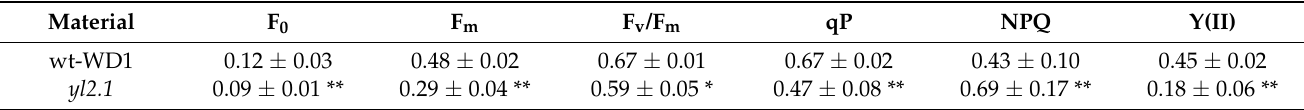
Table 3. Chlorophyll fluorescence kinetic parameters of young leaves of yl2.1 and wt-WD1. For each sample, five indepen- dent biological replications were performed. Each independent biological replication contains three different individuals. Three technical repeats were performed for each biological replication. The average of the three technical repeats was used as the data of one biological replication. Data are means ± SD ( n = 5). Asterisks indicate statistically significant differences compared with the wild-type at ** p < 0.01 and * p < 0.05 by Student’s t -test. Material F 0 F m F v /F m qP NPQ Y(II) wt-WD1 0.12 ± 0.03 0.48 ± 0.02 0.67 ± 0.01 0.67 ± 0.02 0.43 ± 0.10 0.45 ± 0.02 yl2.1 0.09 ± 0.01 ** 0.29 ± 0.04 ** 0.59 ± 0.05 * 0.47 ± 0.08 ** 0.69 ± 0.17 ** 0.18 ± 0.06 **